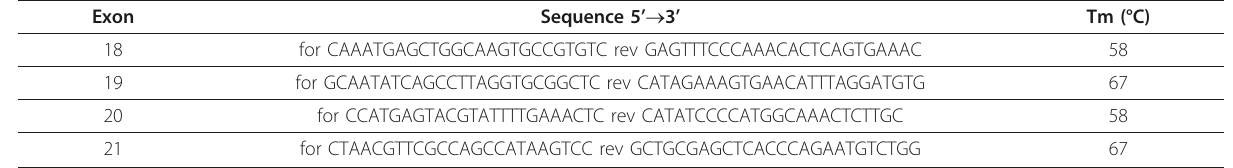
Table 1 Sequences of primers used to amplify and sequence EGFR exons 18 to 21